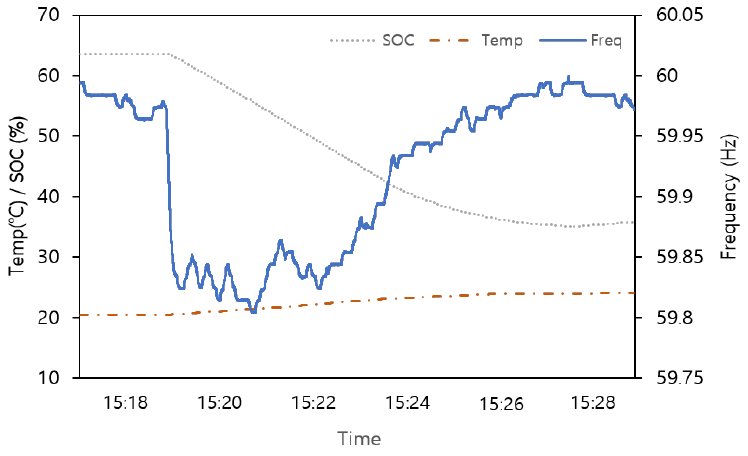
Figure 4. Typical operation profile for the FR BESS transient state.